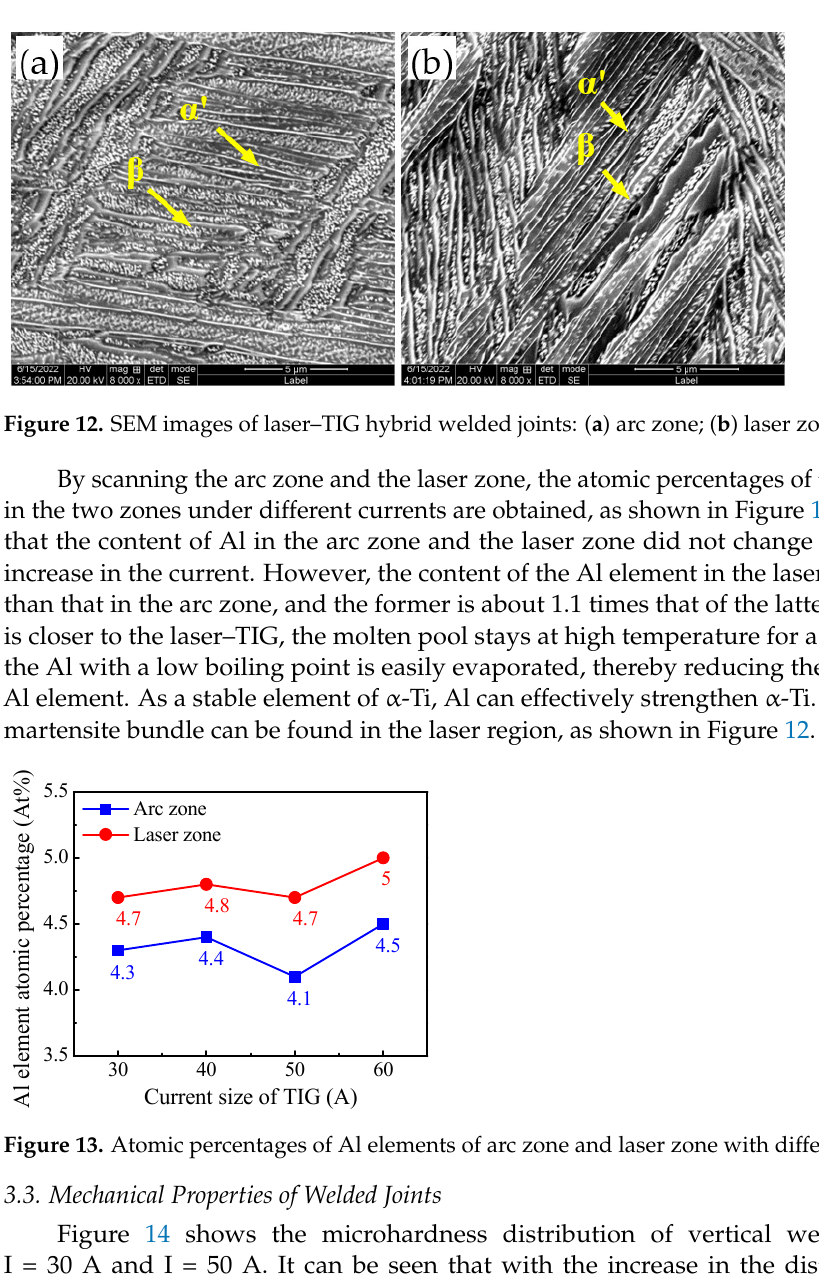
Figure 11. The grains of arc zone with different current sizes: ( a ) I = 30 A; ( b ) I = 40 A; ( c ) I = 50 A; ( d ) I = 60 A. ( d ) I = 60 A.